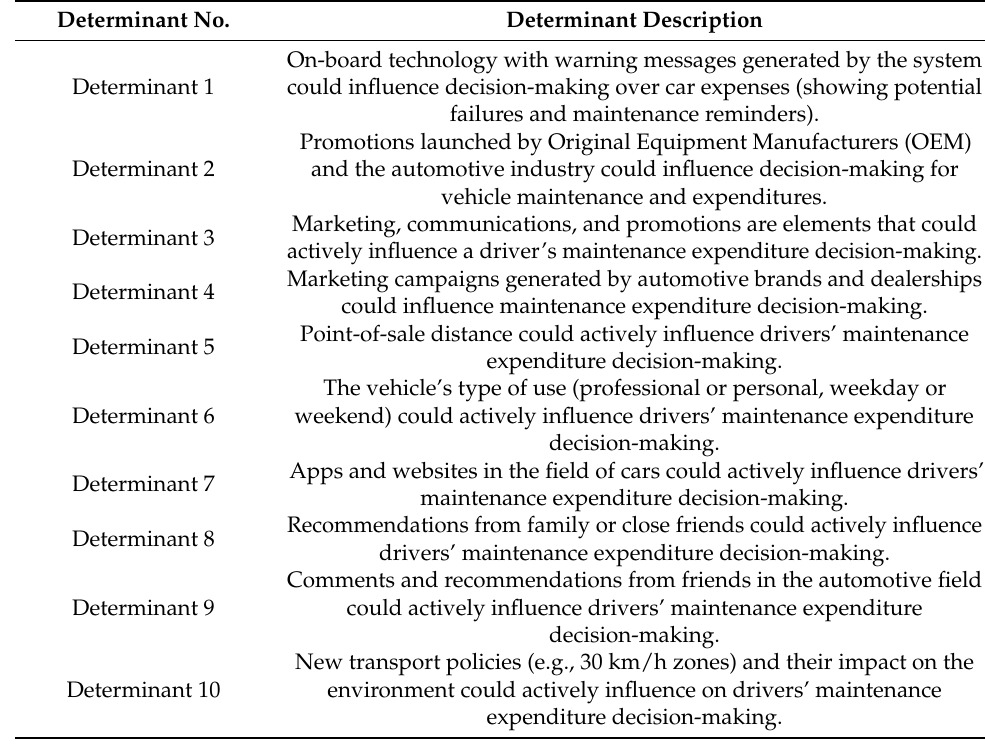
Table 1. Experts’ responses grouped together by the 10 most prominent determinants.